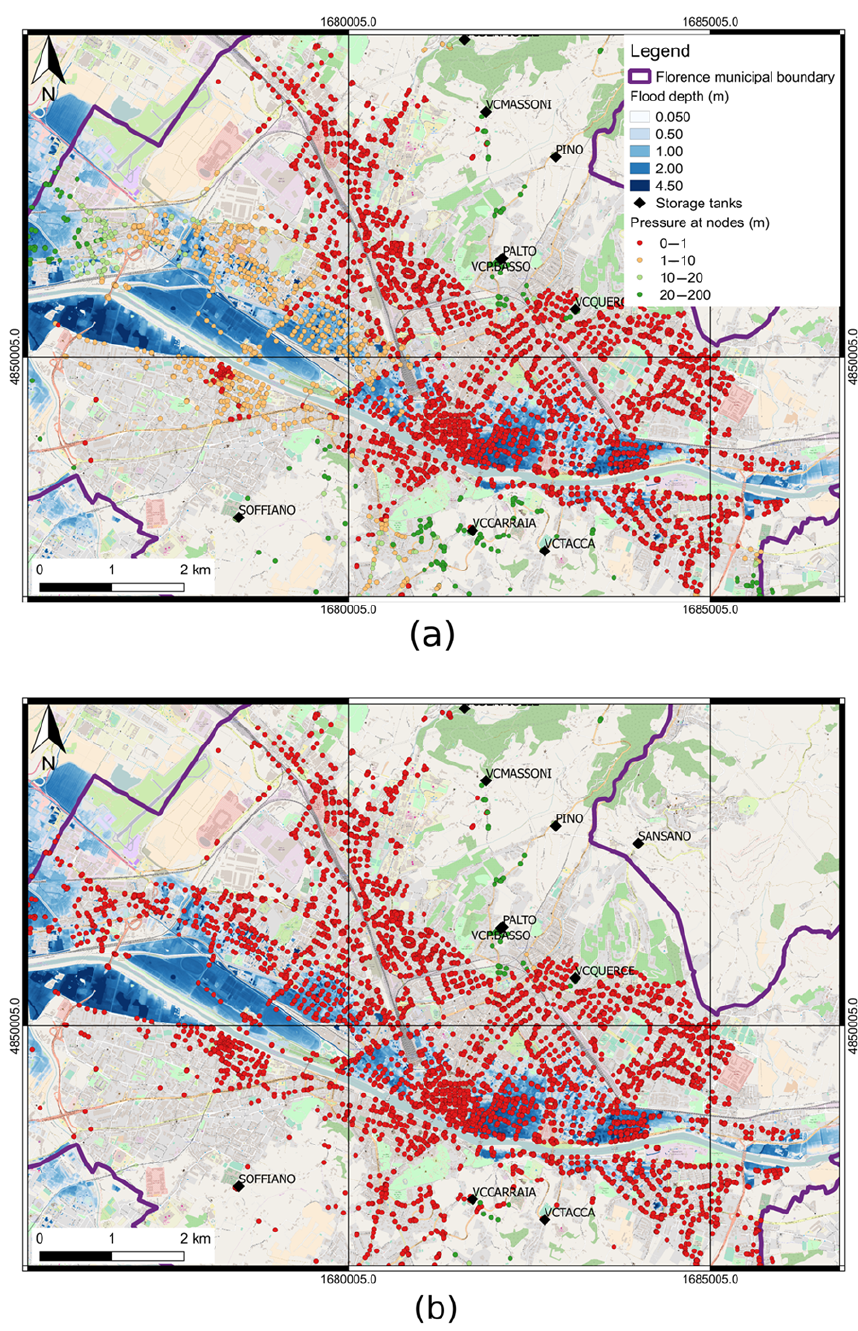
Figure 4. Inundation map and nodal heads for the 500-year recurrence interval, 120min after lifting station failure, for (a) scenario 1 (no pumps on) and (b) scenario 2 (one pump on). Reference coordinate system is